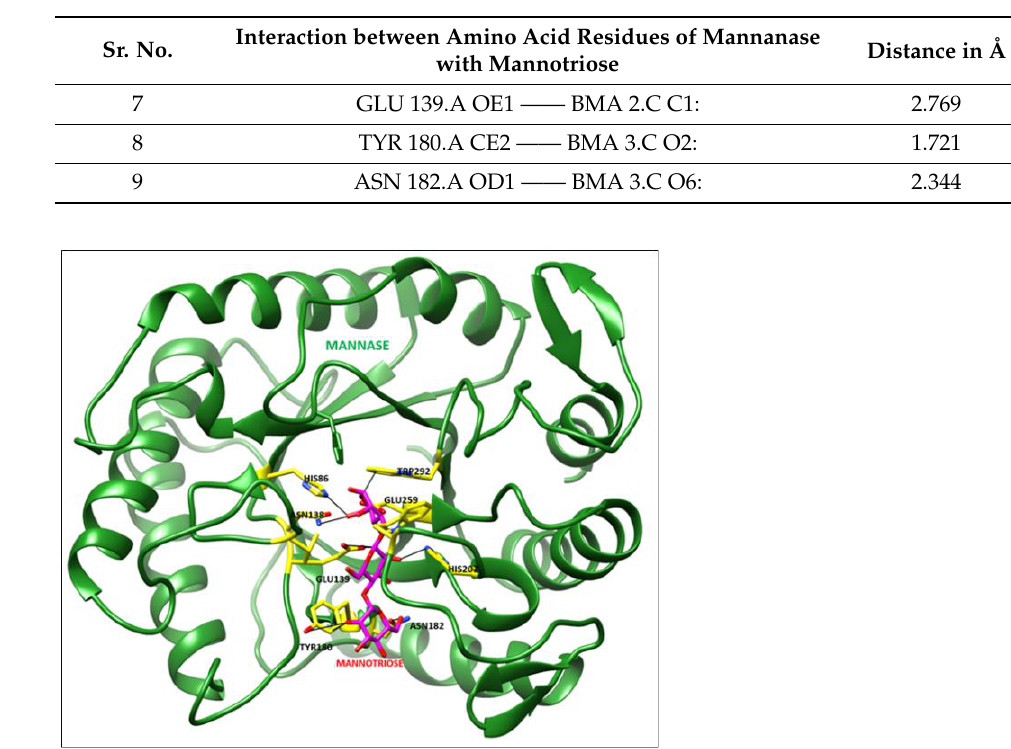
Figure 11. Docked complex of Mannanase (Green) with Mannotriose (Magenta).